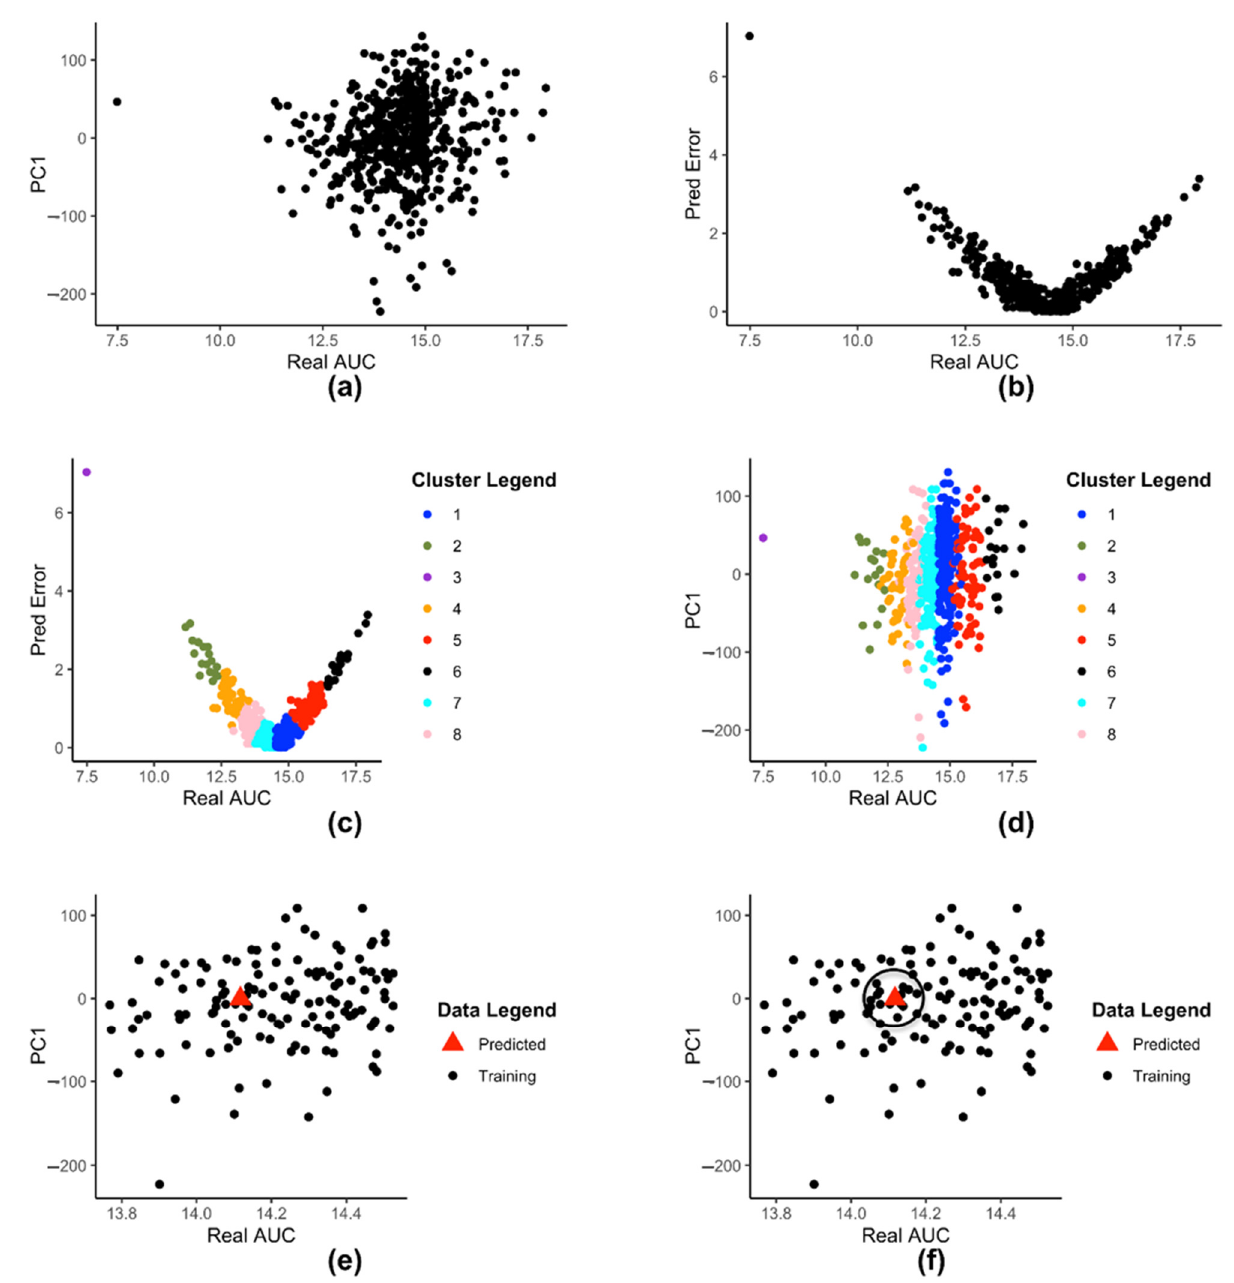
Figure 2. ( a ) 2-D plot of reduced dataset Z ( b ) 2-D representation of prediction error dataset Ψ ( c ) Clustering of Ψ dataset ( d ) 2-D plot of clustered Z ( e ) 2-D plot of data-points in Z with the newly predicted value ( f ) 2-D plot of a predicted data point (cid:4672)(cid:1851)(cid:3364) (cid:3037)(cid:3038) , (cid:2038) (cid:3043) (cid:3435)(cid:1850) (cid:3037) (cid:3439)(cid:4673) and its neighbors